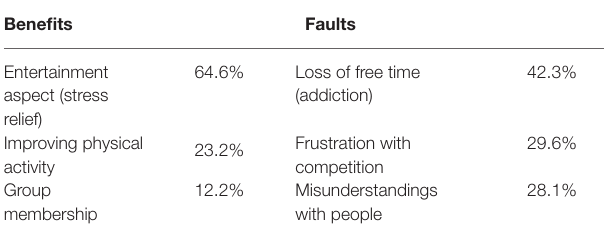
TABLE 1 | Level of physical activity by respondents. Physical activity (walking, running, cycling, etc.)